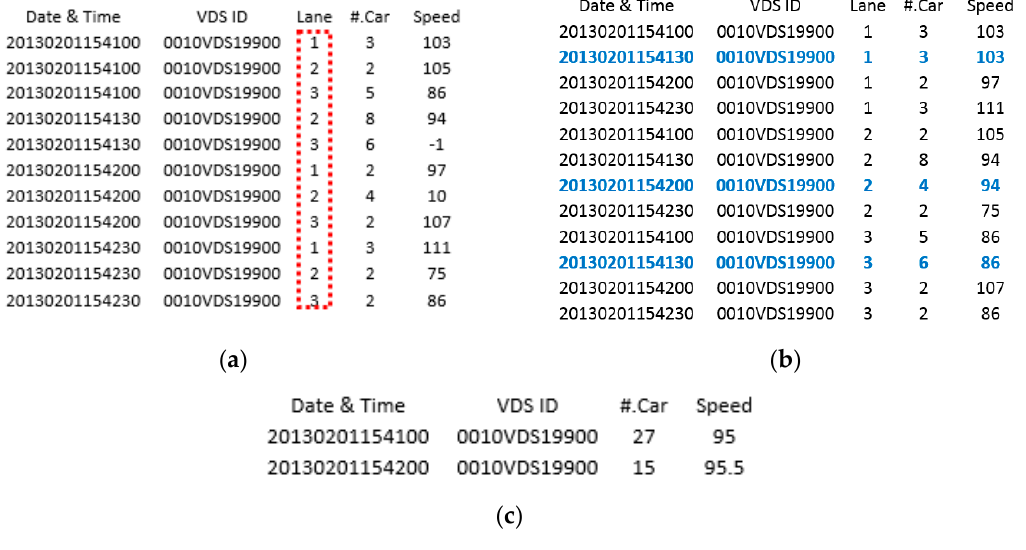
Figure 1. Data filtering and resampling results: ( a ) given raw sensor data, ( b ) noise filtered result, and ( c ) re-sampled result.